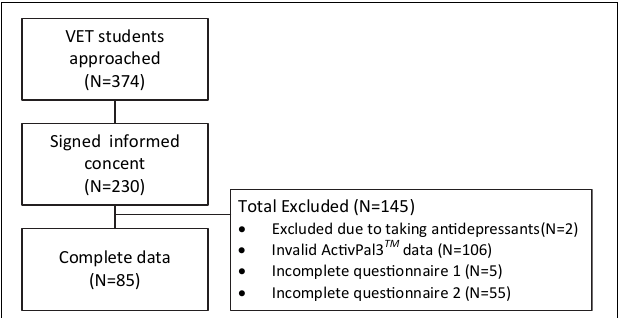
FIGURE 1 | Flowchart of participants. In the total excluded overlap is possible (e.g., a student could have incomplete questionnaire data and invalid ActivPAL3 data